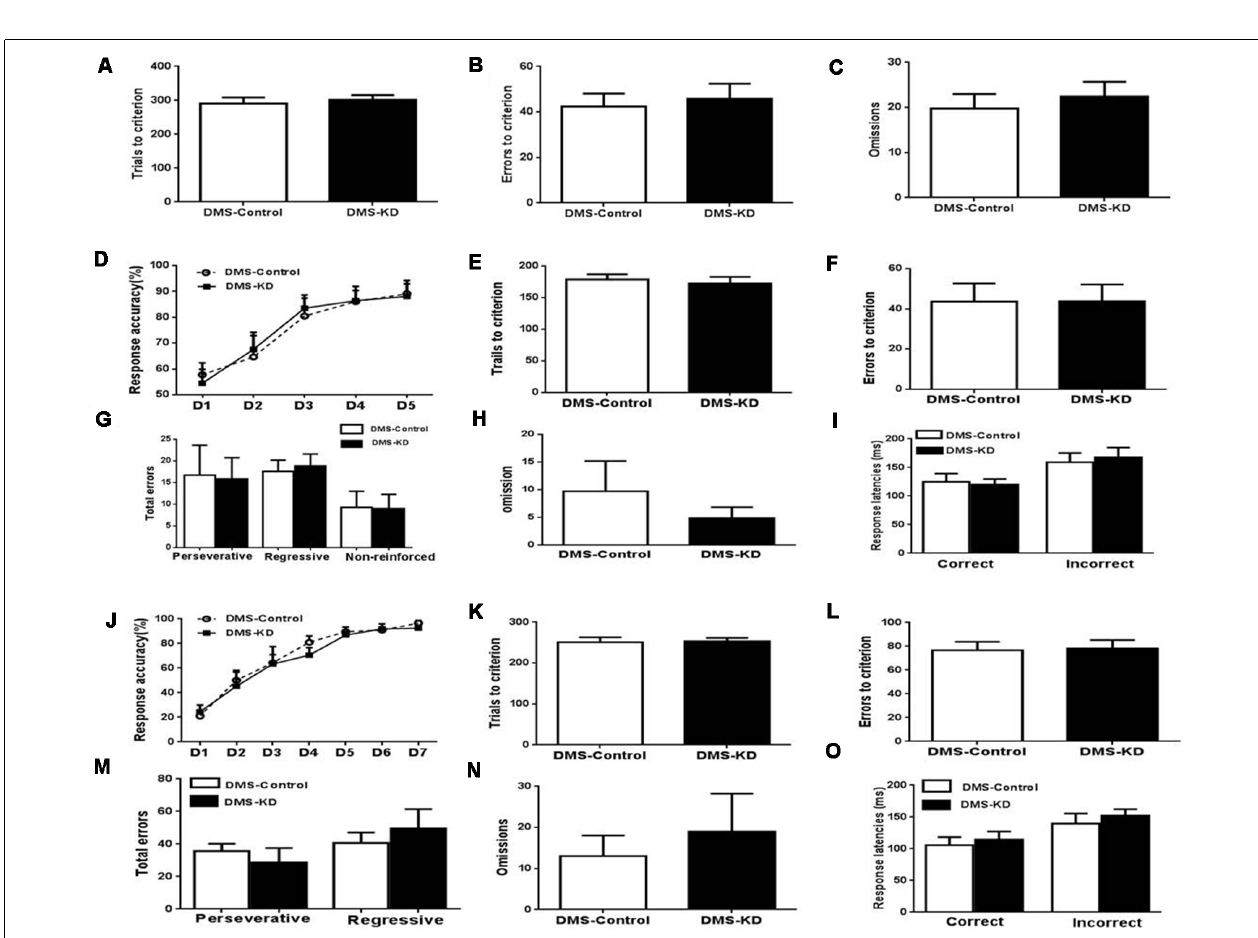
FIGURE 5 | DMS A 2A R KD did not affect visual discrimination, attentional set-shifting, and reversal learning. (A–C) A 2A R KD in the DMS did not affect the performance in task acquisition of visual discrimination (all p > 0.05). (D–I) A 2A R KD in the DMS did not affect the attentional set-shifting. (D) A two-way repeated measures ANOVA showed the main effect of the training session ( F ( 4,48 ) = 54.609, p < 0.01), but no effect of the manipulation ( F ( 1,12 ) = 0.17, p = 0.9) and training × manipulation interaction ( F ( 4,48 ) = 0.412, p = 0.799). (E–I) There was no significant difference in the trial number ( p = 0.6328), learning errors ( p = 0.991), omission ( p = 0.4199) and response latencies ( p > 0.05). (J–O) Knockdown of A 2A Rs in the DMS did not affect reversal learning. (J) Response accuracy analysis revealed the session-dependent learning rates across DMS A 2A R KD and control groups ( F ( 4,32 ) = 37.371, p < 0.01, two-way ANOVA with repeated measures), but no group difference ( F ( 1,8 ) = 0.175, p > 0.05, first 5 days) and group × session interaction effect ( F ( 4,32 ) = 0.382, p > 0.05). (K–O) DMS A 2A R KD did not affect total trials, errors to criterion, omissions, and response latencies, as compared to the control group (all p >